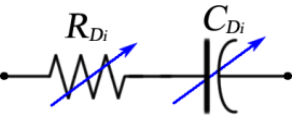
Figure 12. Equivalent electrical diagram for the drag force applied to a blade